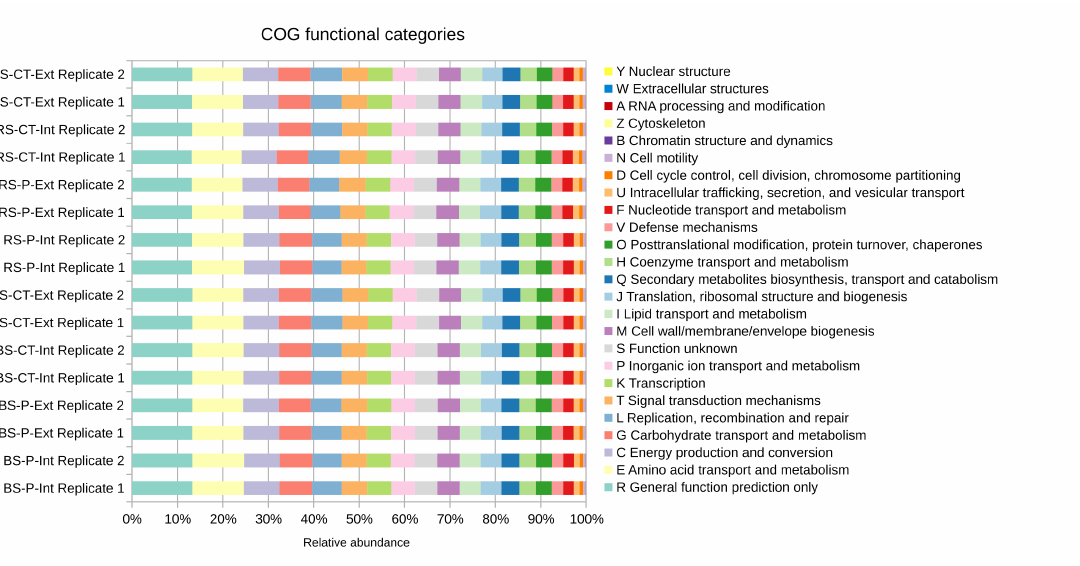
Figure 3. Functional profiling on the level of Clusters of Orthologous Groups of proteins (COG) functional categories of the microbial communities residing in the differently treated LTE-1 soils based on direct classification of reads. Relative abundances were determined based on direct classification of reads normalized to the dataset sizes (fractions). Colors are ordered right-to-left according to the legend top-down. Abbreviations stand for bulk soil (BS) or root-affected soil (RS), tillage by mould-board plough (P) or cultivator (CT), and nitrogen fertilization intensive (Int) or extensive (Ext). 3.3. Assembly of Metagenomic Reads Yielded Approx. 6.9 Mio. Genes Characterizing the LTE-1